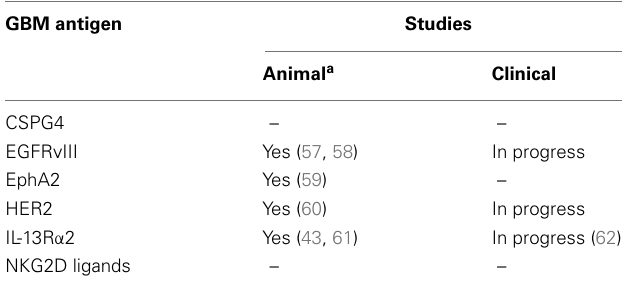
Table 2 | CAR T-cell therapy targets for GBM